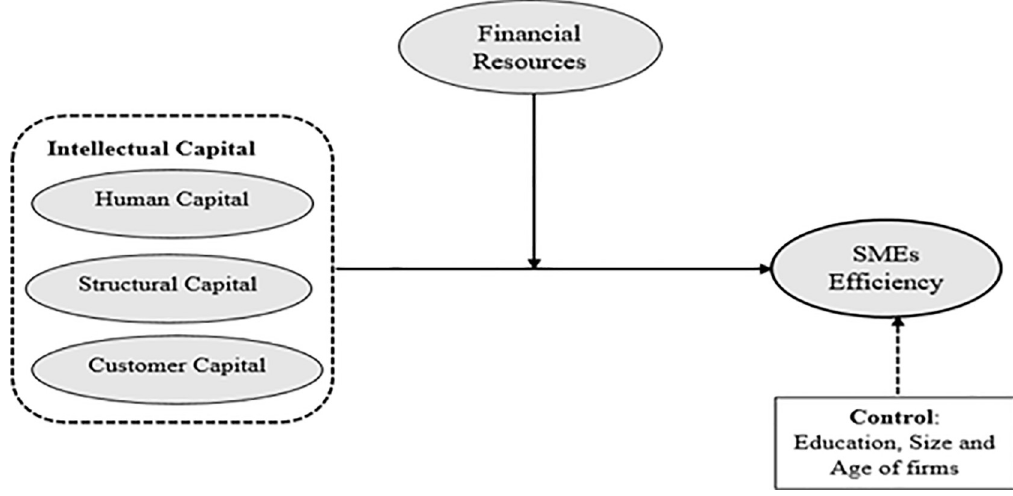
Fig 1. Model of the